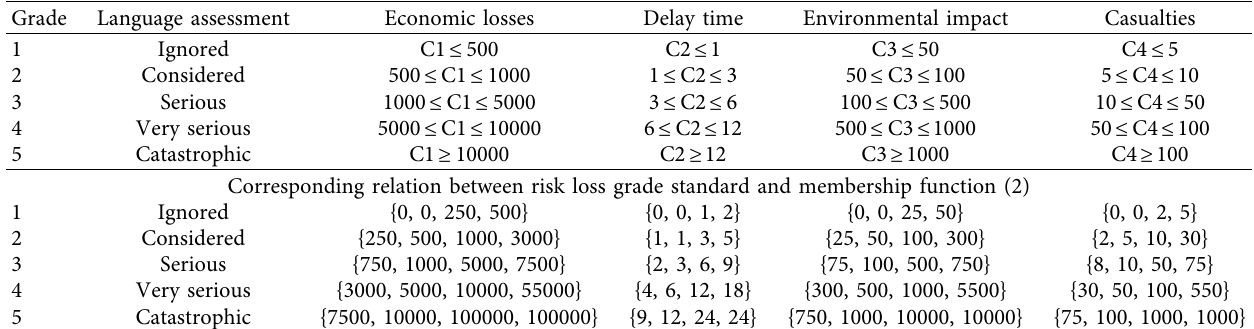
Table 4: Corresponding relation between risk loss grade standard and membership function (1).